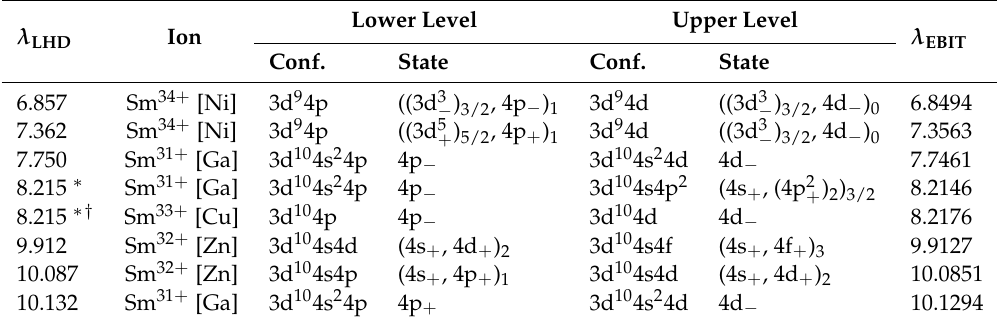
Table 3. The assignments of the lines of samarium ions indicated by arrows in the bottom panel of Figure 1. The assignments are based on a comparison with the NIST EBIT data at a beam energy of 1.25–2.20 keV [29]. Isoelectronic sequence of each ion is shown in a square bracket. The states of the lower and upper levels are denoted in jj coupling notation. All wavelengths are in